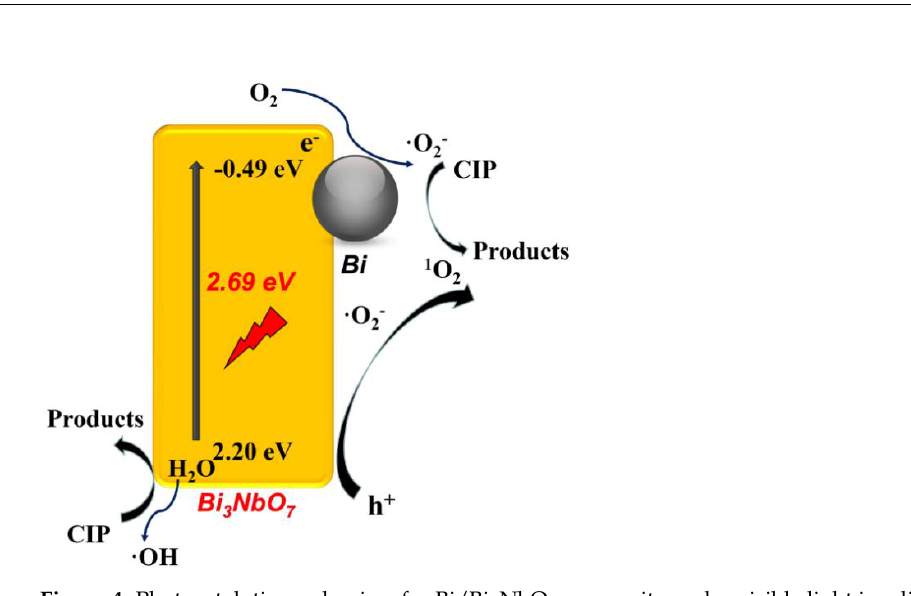
Figure 4. Photocatalytic mechanism for Bi/Bi 3 NbO 7 composite under visible light irradiation